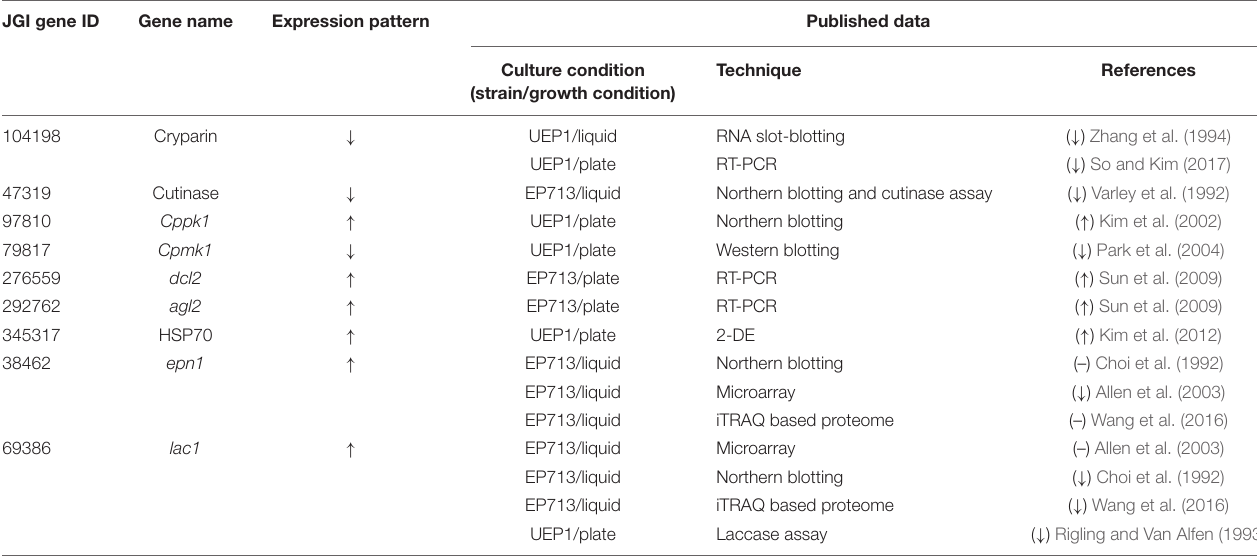
FIGURE 2 | Validation of the expression of 20 randomly selected DEGs using RNA-seq and qRT-PCR analysis. Log 2 FC is calculated from the mean of three samples. The coefficient of determination ( R 2 ) is displayed. TABLE 2 | Comparison of transcriptome responses to hypovirus and published